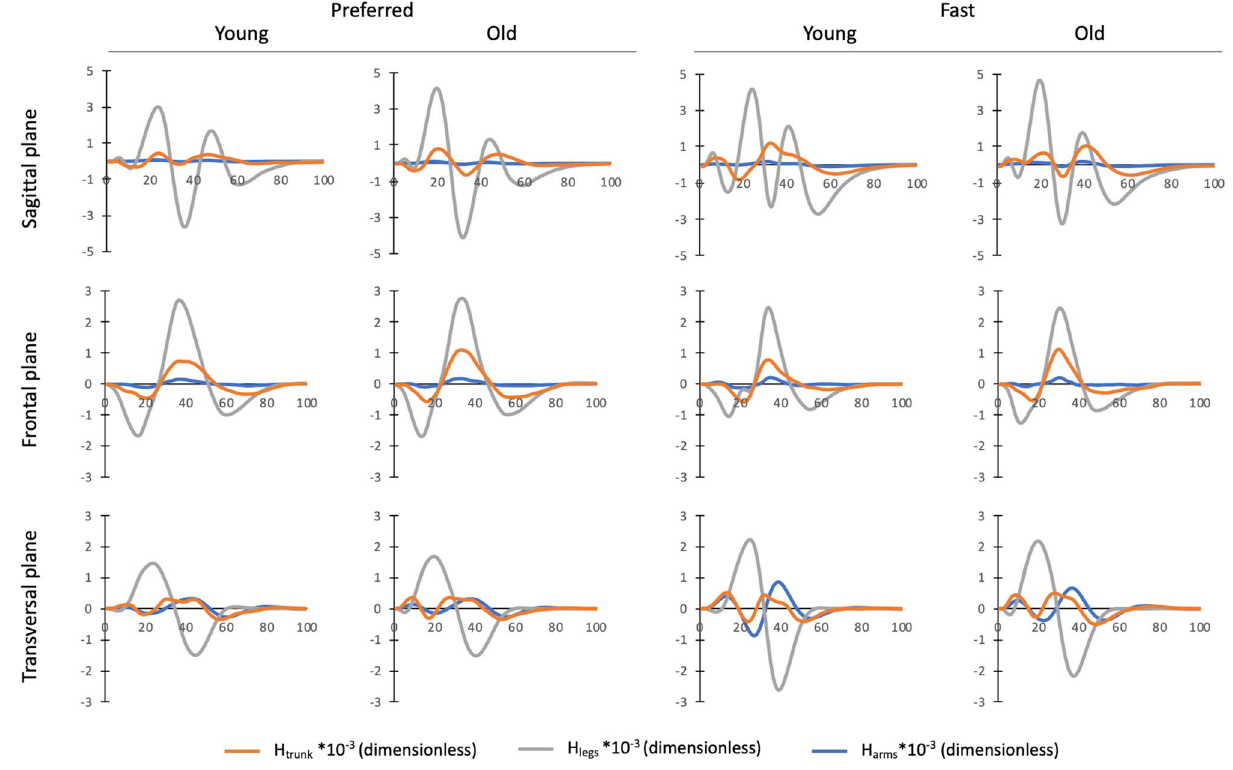
Figure 6. Mean normalized angular momenta of the trunk (H trunk ), legs (H legs ) and arms (H arms) over the entire stepping movement (0–100%) for old and young individuals in both speed conditions. Segment angular momenta were normalized by body mass, body height and (cid:31) g · l ( g = 9.81 m s −2 and l = body